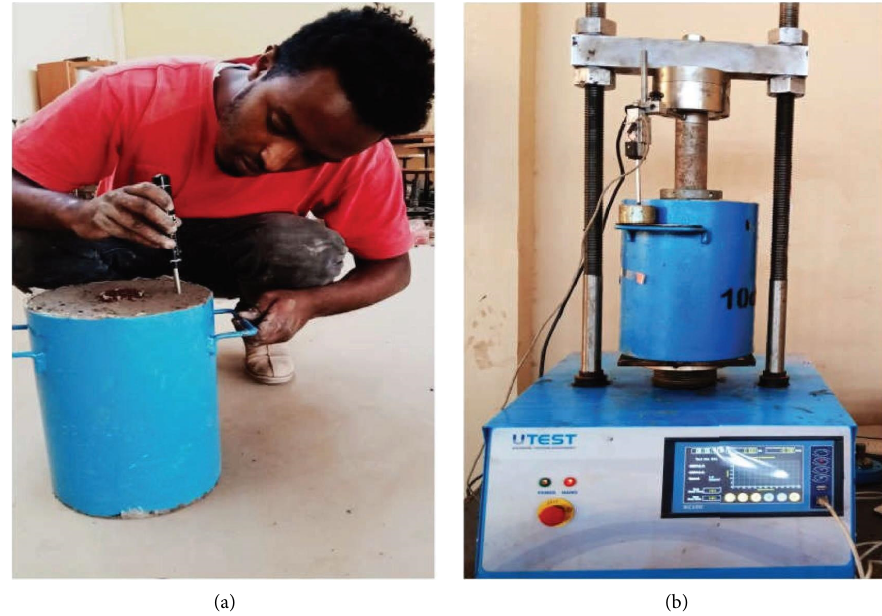
Figure 9: (a) UCS test using pocket penetrometer, and (b) the overall test model subjected to footing